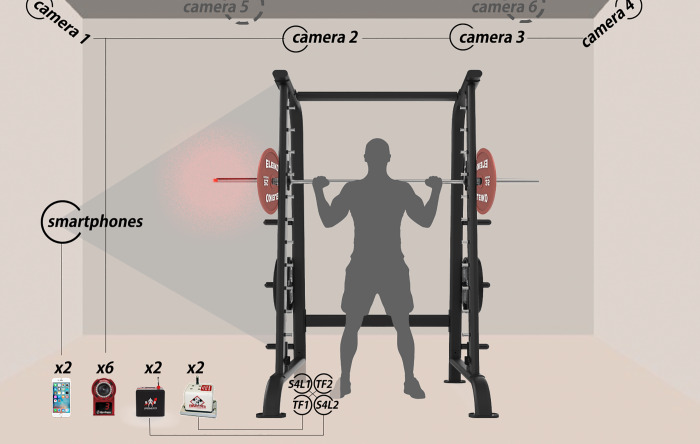
Experiment set up.